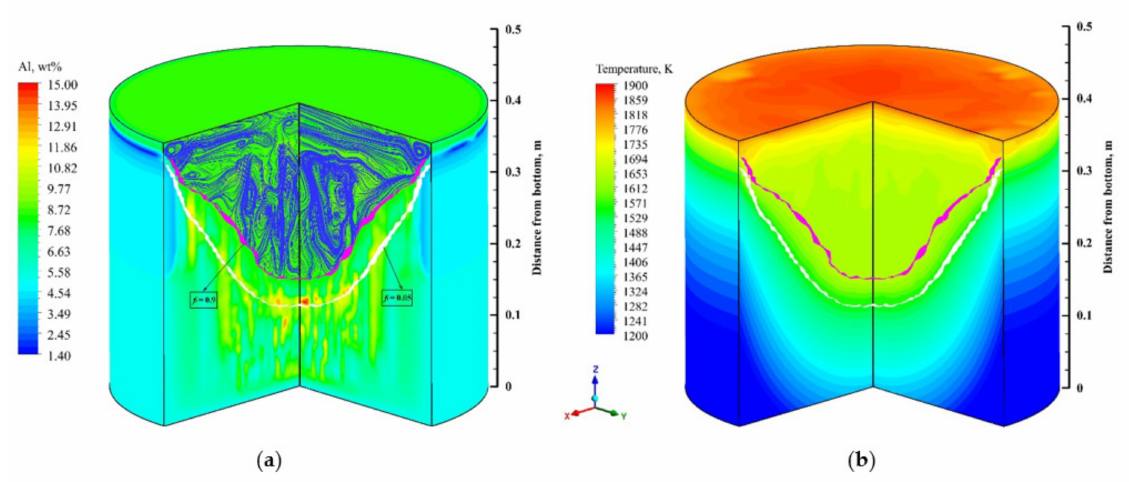
Figure 10. Results at time t = 3500 s: ( a ) streamlines and solute distribution; ( b ) temperature